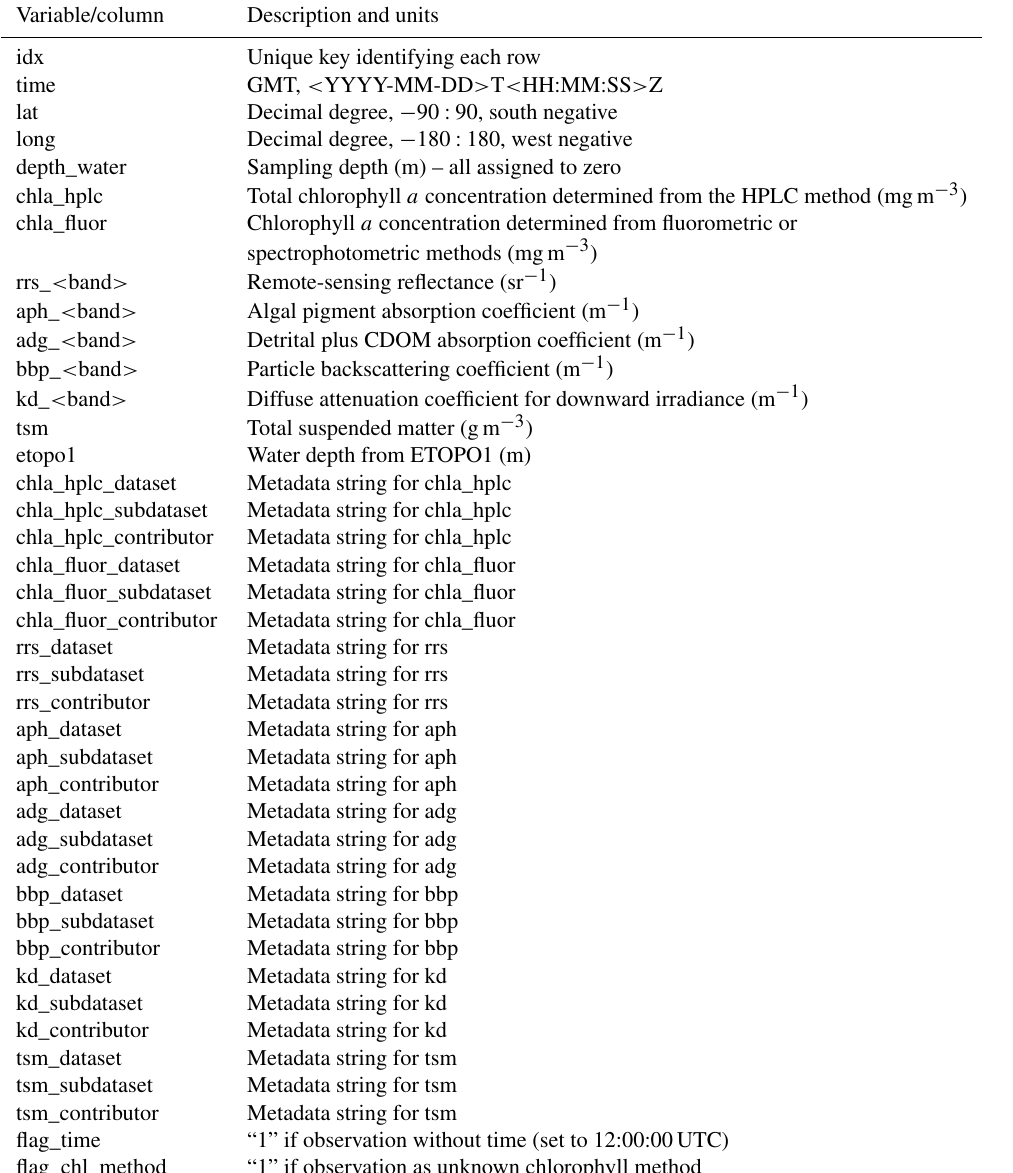
Table 1. The standard variables, nomenclatures and units in the final table. Variable/column Description and